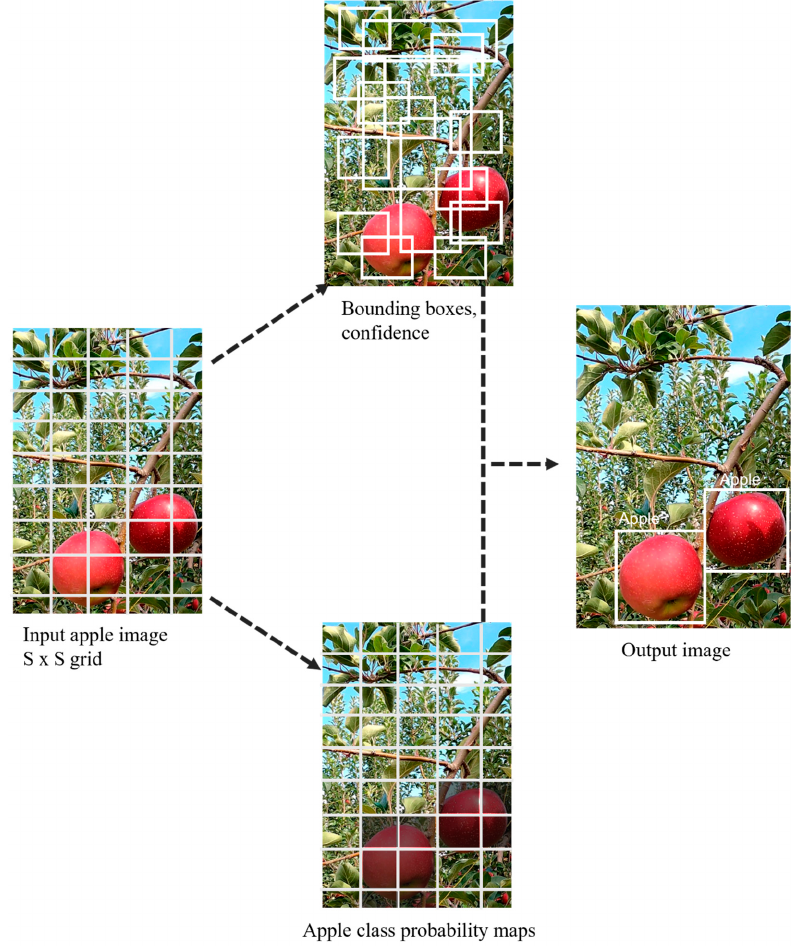
Figure 5. Apple detection based on bounding boxes for the YOLO ‐ based CNN structure.